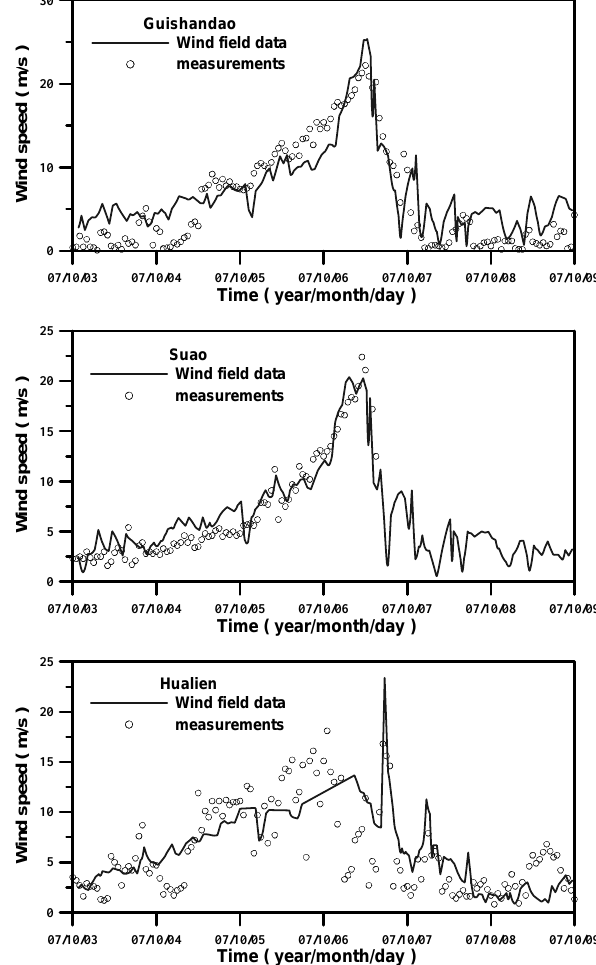
Fig. 4. Wind velocity measured by the buoys and hindcasted by CWB.